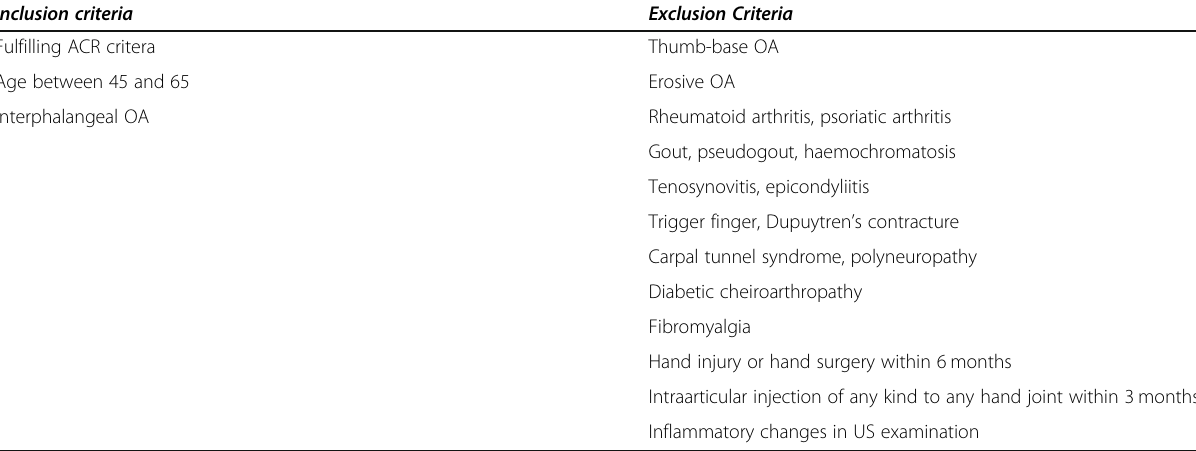
Table 1 Inclusion and exclusion criteria Inclusion